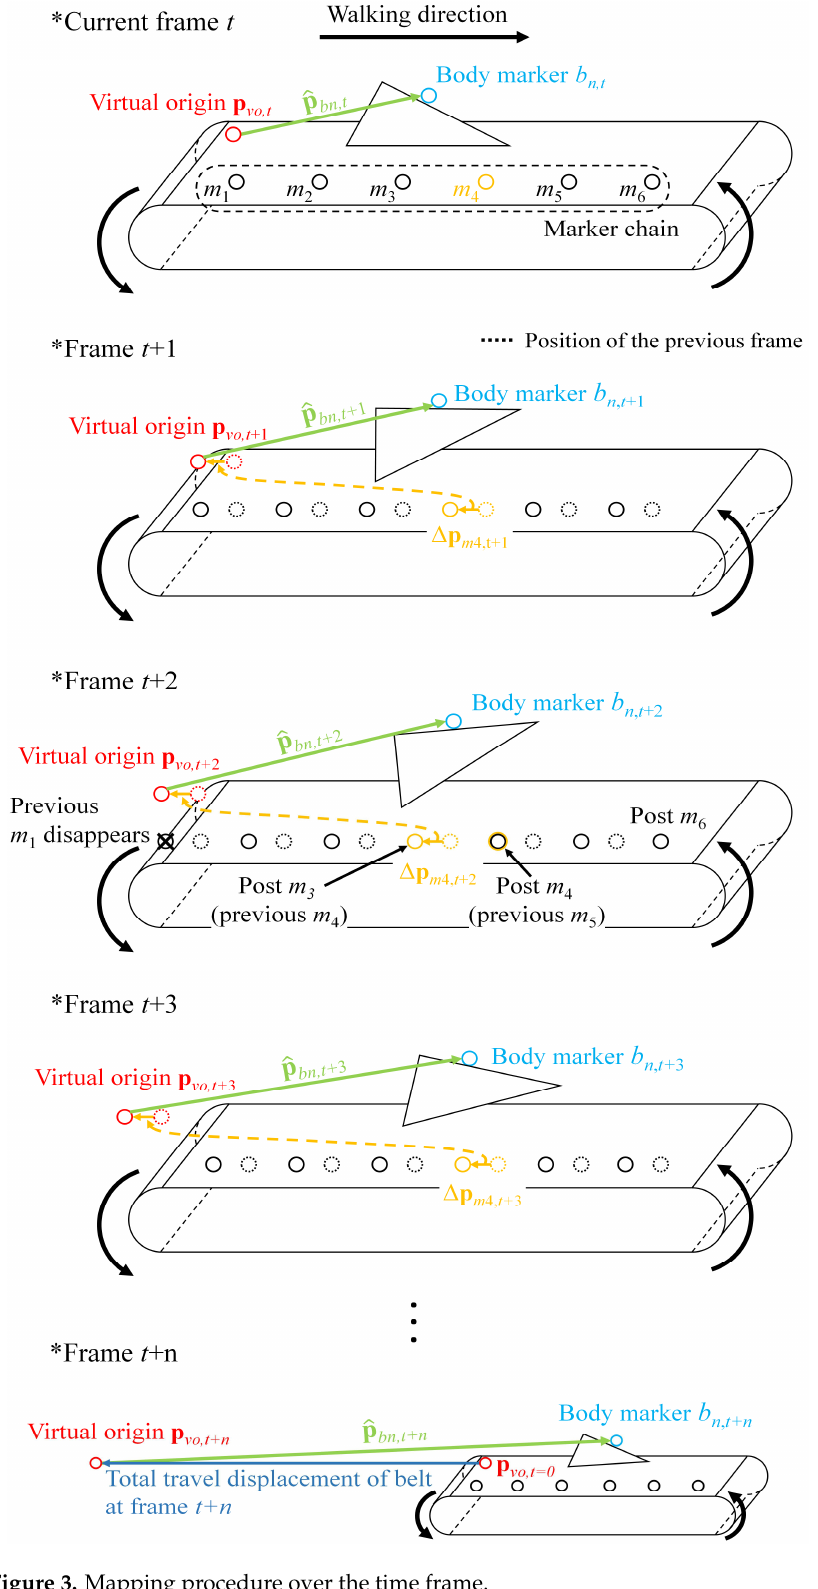
Figure 3. Mapping procedure over the time frame.